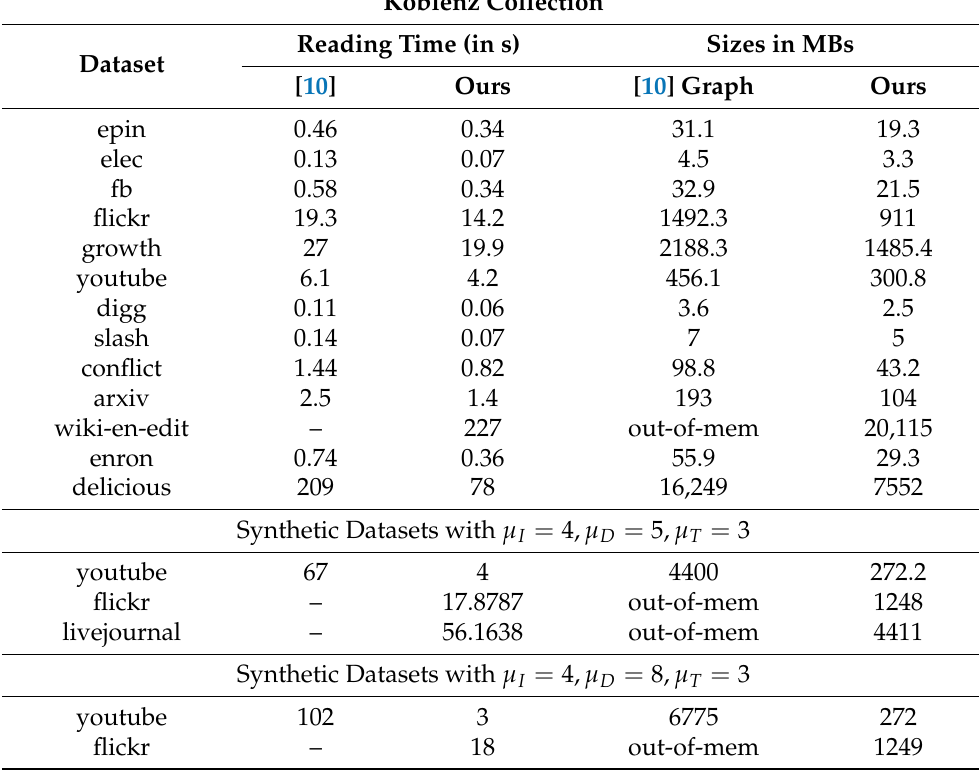
Table 3. Reading times and